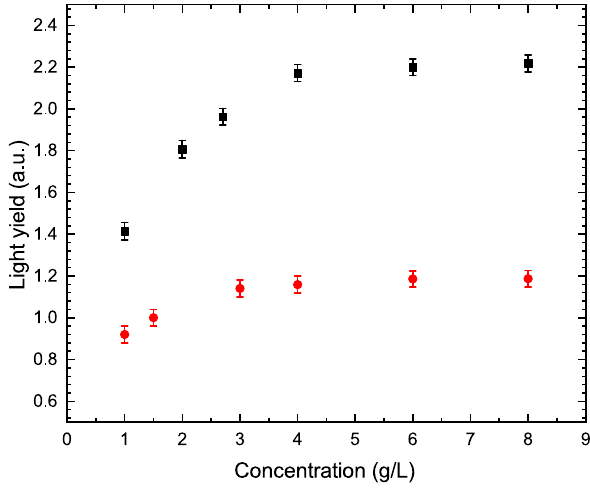
Fig. 5 Dependence of the light yield on the concentration of the NOL 37 (black colour) and PPO (red colour) fluors